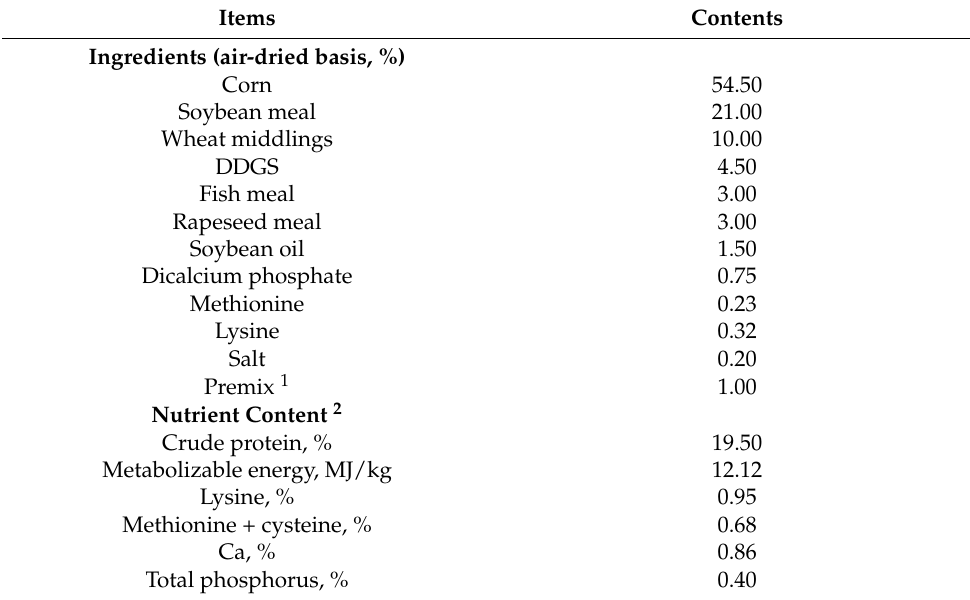
Table 1. Diet composition and nutritional